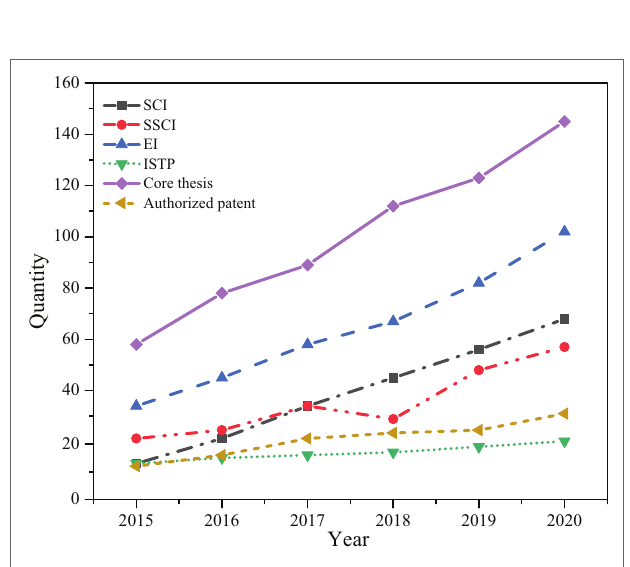
FIGURE 13 | Statistics of scientific research achievements.